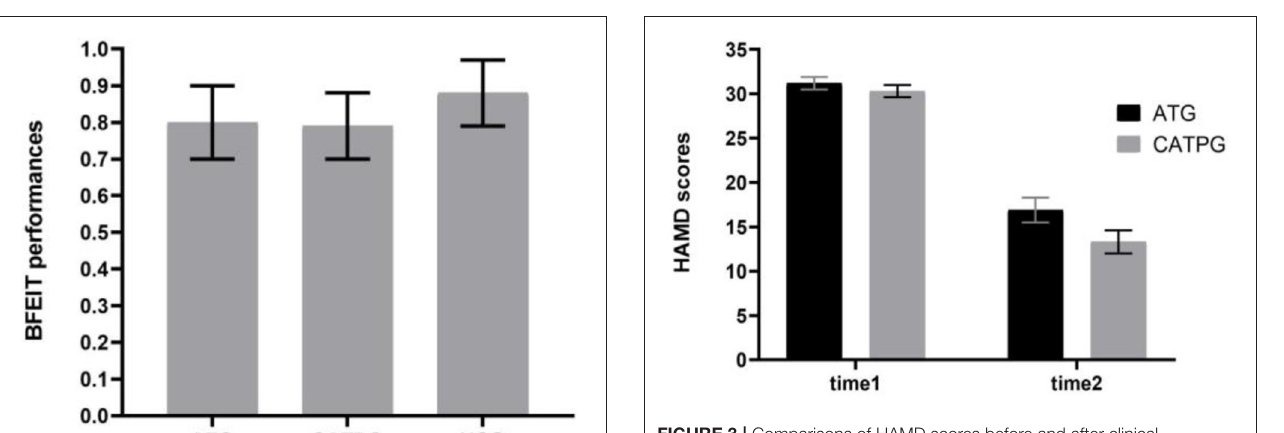
FIGURE 3 | Comparisons of HAMD scores before and after clinical interventions between the AT group and CATP group. HAMD, Hamilton Depression Rating Scale (17-item version); ATG, antidepressant treatment group; CATPG, the combination of antidepressant treatment and PST group; time 1, baseline; time 2, after 12 weeks of intervention; SD, standard